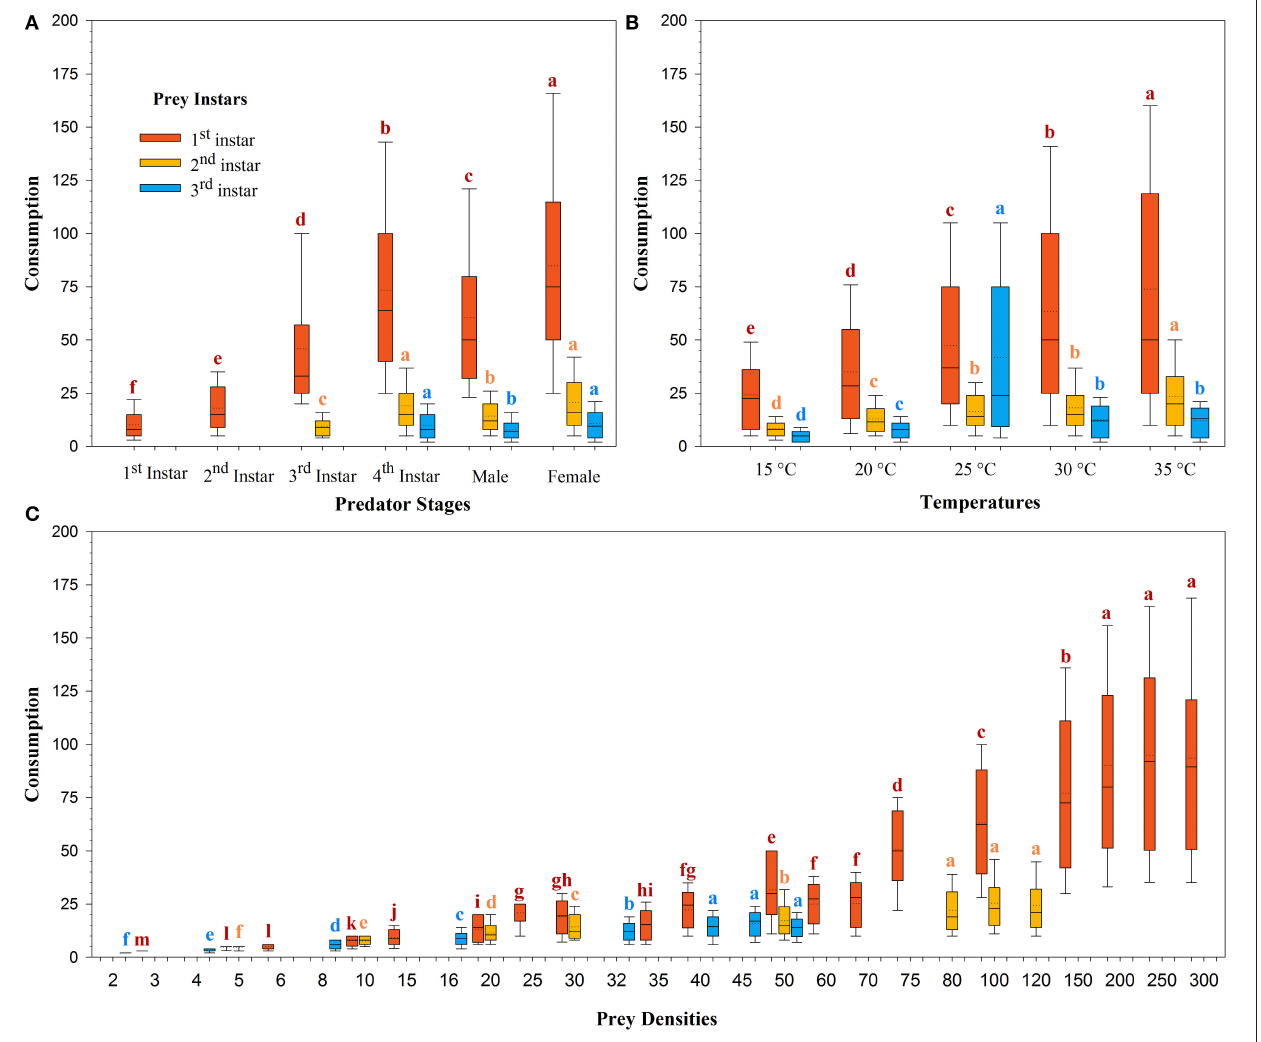
FIGURE 2 | Consumption of prey Spodoptera litura by Harmonia axyridis at five temperatures, according to predator stage (A) , temperatures (B) , and prey densities offered (C) . Box plots show the range of data (lower and upper quartiles), median (line), and mean (dotted line), and different lowercase letters above the whisker caps indicate significant differences among group mean values according to 95% CI. Number of replications (N) =